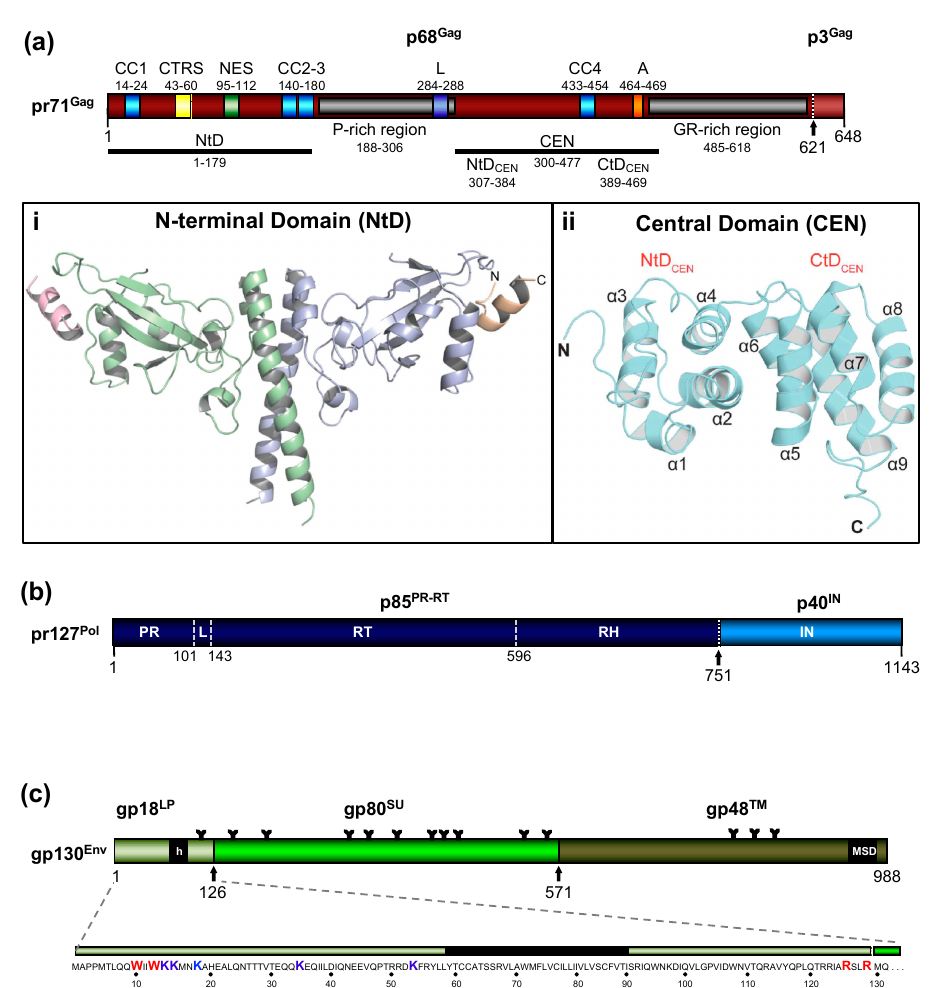
Figure 2. Schematic representation of the FV Gag, Pol, and Env protein organization. ( a ) Schematic illustration of the PFV Gag protein organization and selected functional motifs. Several functional motifs of PFV Gag are highlighted in differently colored boxes. Numbers indicate amino acid (aa) positions of the PFV Gag protein. The black arrow marks the cleavage site of pr71 Gag for processing into p68 Gag and p3 Gag . Gray boxes represent the proline-rich (PR-rich) and glycine-arginine-rich (GR-rich) regions respectively. CC1 to CC4: coiled-coil domain 1 to 4; CTRS: cytoplasmic targeting and retention signal; NES: nuclear export sequence; L: late budding domain motif; A: assembly motif. ( i ) Cartoon representation of the three-dimensional (3D) structure of the PFV Gag N-terminal domain (NtD, aa 1–179) homodimer in complex with Env leader protein (Elp/LP) peptides. The Gag-NtD monomer-A is shown in pale blue and monomer-B in green. The helical Elp/LP peptides bound at the periphery of each head domain are colored magenta and gold with N and C termini indicated ( ii ) Cartoon representation of the 3D structure of the PFV-Gag central domain (CEN, aa 300–477) with its two subdomains NtD CEN and CtD CEN . The peptide backbone is shown in cyan. The secondary structure elements are numbered sequentially from the amino-terminus and the N and C termini are indicated. Helices α 1 to α 4 and α 5 to α 9 that comprise NtD CEN and CtD CEN , respectively, are indicated. ( b ) Schematic illustration of the PFV Pol protein organization. Numbers indicate aa positions of the PFV Pol protein. The black arrow marks the cleavage site of pr127 Pol for processing into p85 PR-RT-RH and p40 IN . PR: protease domain; L: linker sequence; RT: reverse transcriptase domain; RH: RNase H domain; IN: integrase domain. ( c ) Schematic organization of PFV Env protein. The furin cleavage sites within the gp130 Env precursor that are used for generation of the mature gp18 LP , gp80 SU , and gp48 TM subunits are indicated by arrows. The individual subunits are shown as boxes in different shades of green. Hydrophobic sequences spanning the membrane in Elp/LP (h) and transmembrane (TM) (membrane-spanning domain, MSD) subunit are indicated. The aa sequence of the PFV Env Elp/LP subunit is shown in the enlargement below. The conserved WxxW and RxxR motif are highlighted in red, the lysine residues potentially ubiquitinated are highlighted in blue. The approximate positions of PFV Env N-glycosylation sites are marked by Y-shaped symbols. Panel ( a , b , c ) adapted from [3,8,22]; panel ( ai ) adapted from [25]; panel ( aii ) adapted from